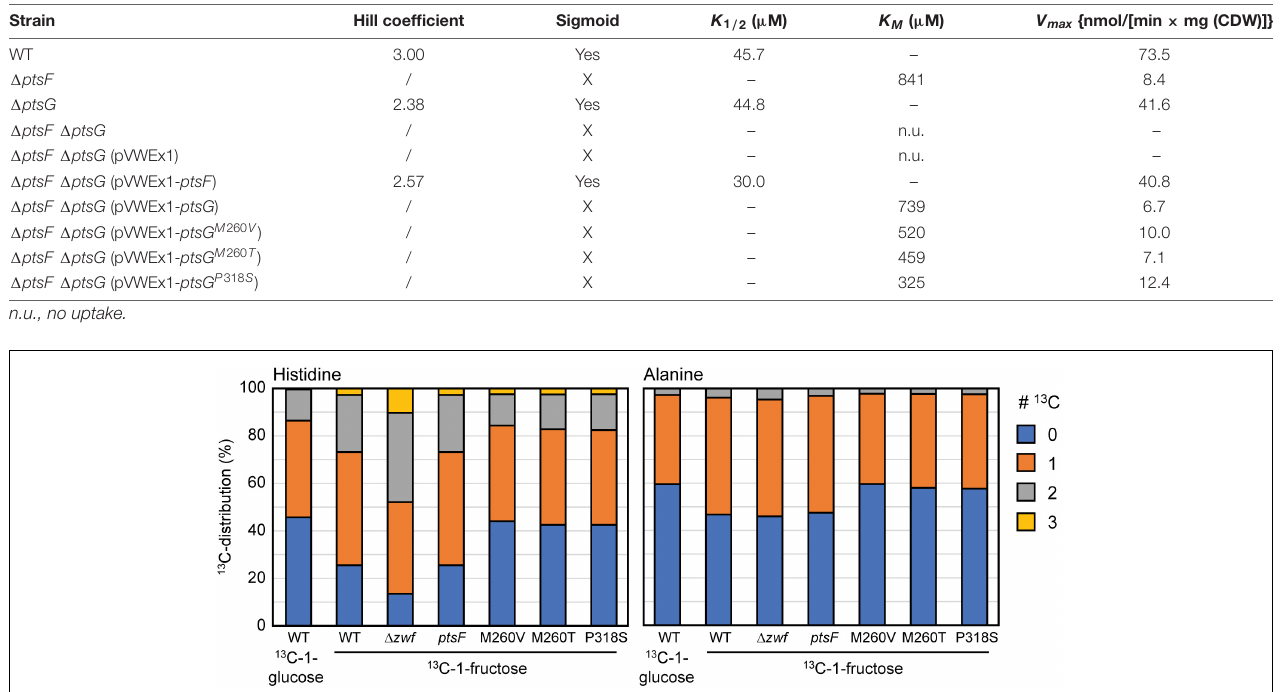
FIGURE 6 | 13 C-labeling in L -histidine and L -alanine in WT, (cid:49) zwf , and the (cid:49) ptsF (cid:49) ptsG strain overexpressing ptsF or the ptsG variants upon feeding 13 C-1-fructose or 13 C-1-glucose. Data represent means of three independent experiment errors < 5%.